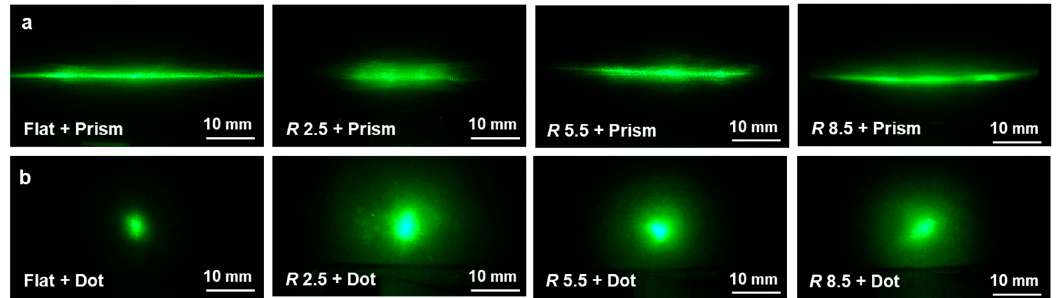
Figure 10. Comparison of light diffusion characteristics of curved polyethylene terephthalate (PET) films containing micropatterns: ( a ) prism pattern; ( b ) dot pattern.